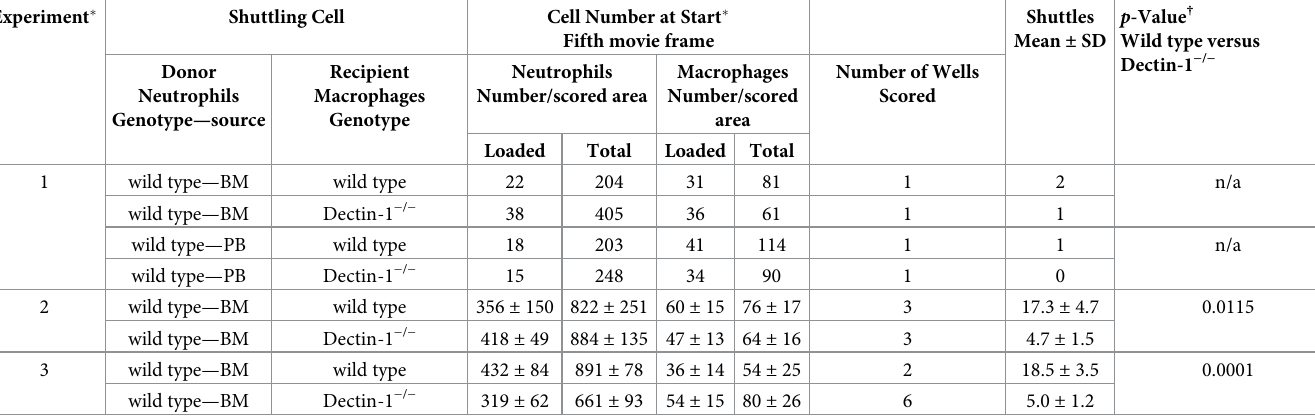
Table 1. Zymosan–pHrodo shuttling involving Dectin-1–deficient recipient murine macrophages. Experiment